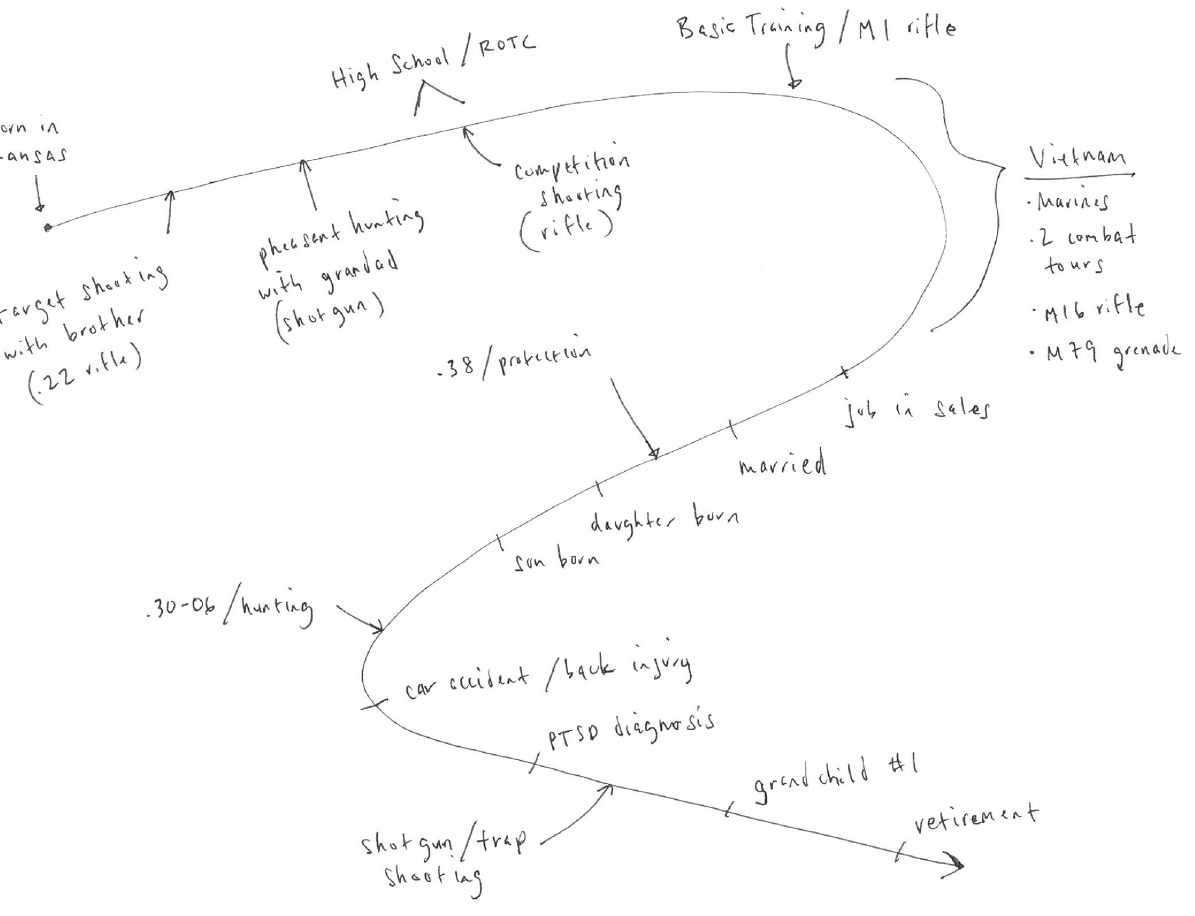
Fig 1. Fictional life